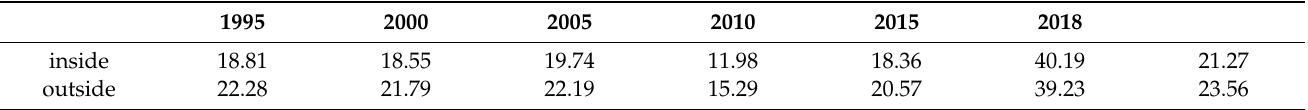
Table 7. Modulus of soil erosion in different years inside and outside the environmental